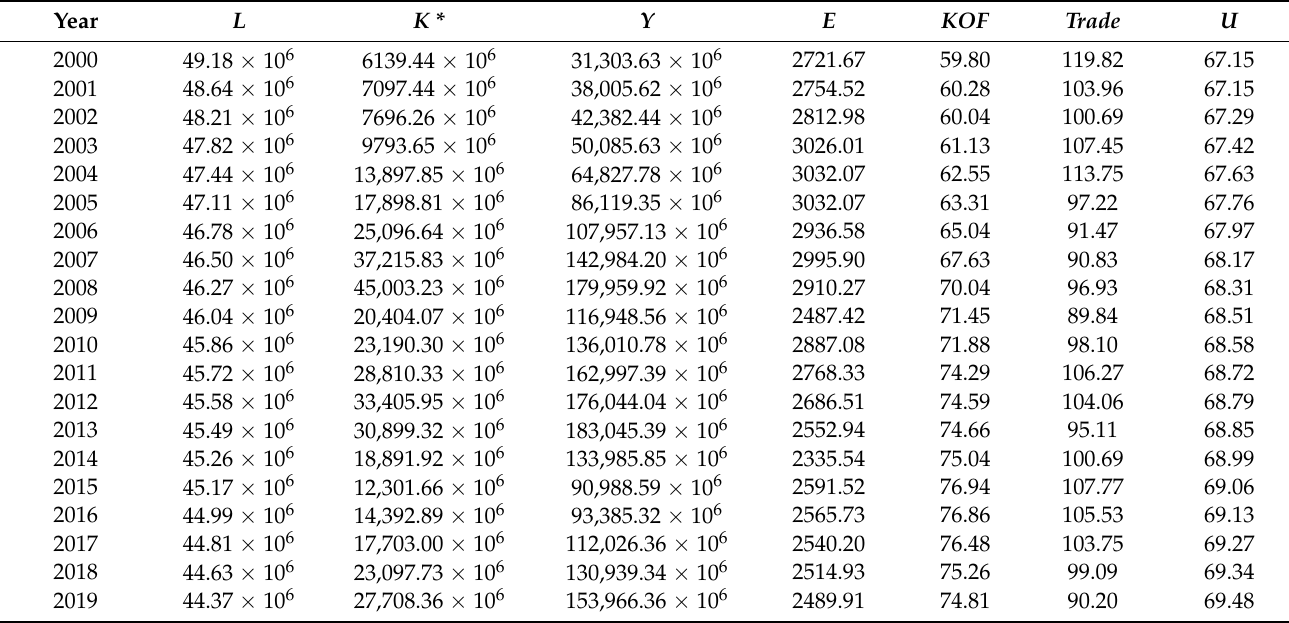
Table 1. Baseline data for estimating energy efficiency gaps in the national economy.